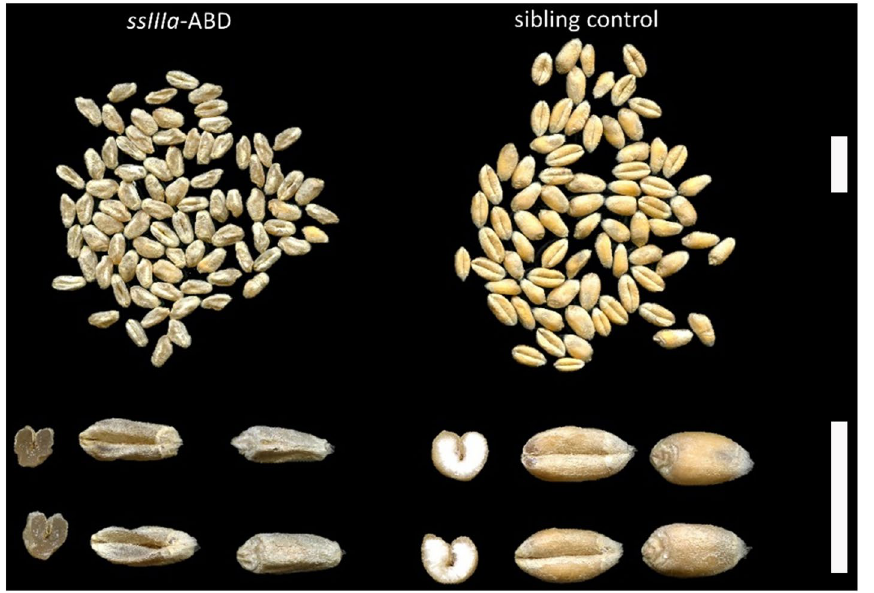
Figure 2. Whole grains and cross-sections of the ssIIIa -ABD triple mutant (left) and sibling control (right). Size bars represent 1